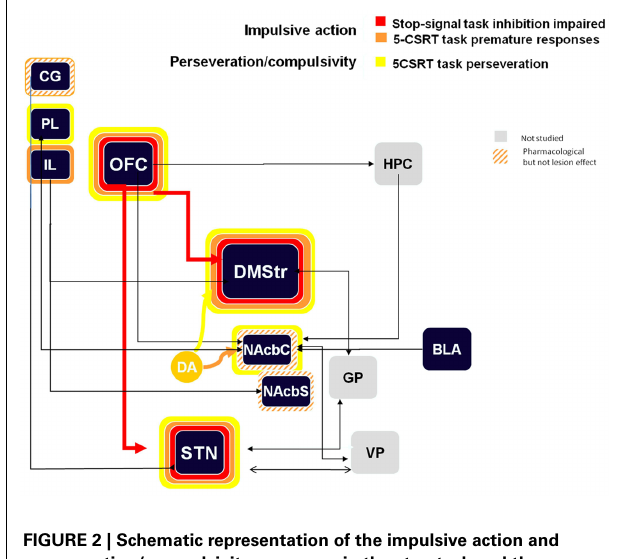
FIGURE 1 | Schematic representation of the impulsive action processes in the stop task and the 5-CSRTT (premature responses) from lesion and pharmacological manipulations. Colored bands surrounding each structure highlight the impulsive-like effect of the lesion of the given structure. Hatched–shaded bands indicate no effect of excitotoxic lesion, but an effect under pharmacological manipulation or other conditions). Gray structures indicate that no information is available. Arrows materialize anatomical connections between regions. CG, cingulate cortex; PL, pre-limbic cortex; IL, infra-limbic cortex; OFC, orbito-frontal cortex; HPC, hippocampus; DMStr, dorso-medial striatum; NAcbC, nucleus accumbens core; NAcbS, nucleus accumbens shell; GP, globus pallidus; BLA, basolateral amygdale; STN, subthalamic nucleus;VP, ventral pallidum.